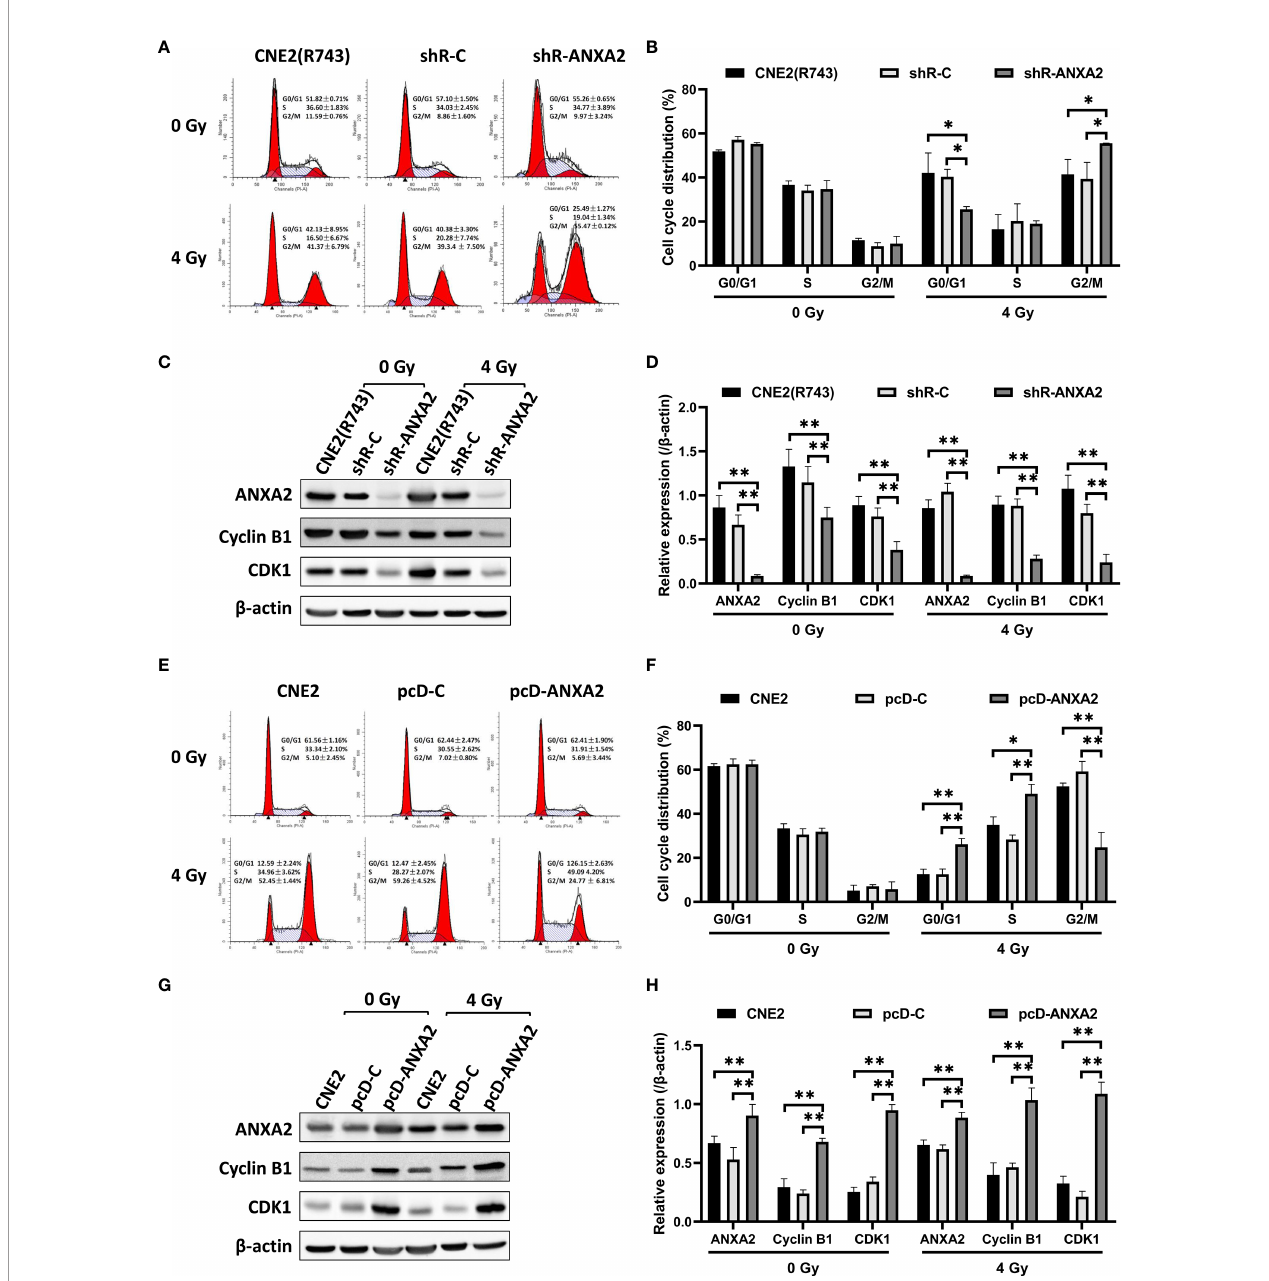
FIGURE 5 | ANXA2 knockdown induces and ANXA2 overexpression abrogates G2/M cell cycle arrest in NPC cells following irradiation. (A) fl ow cytometric analysis detects the cell cycle distribution of shR-ANXA2, shR-C and CNE2(R743) cells 24 h post-exposure to irradiation at doses of 0 and 4 Gy; (B) the percentage of shR- ANXA2 cells with G2/M cell-cycle arrest is signi fi cantly higher than those of shR-C and CNE2(R743) cells 24 h following exposure to irradiation at 4 Gy, no signi fi cant difference is seen in the percentage of shR-ANXA2, shR-C and CNE2(R743) cells with G2/M cell-cycle arrest without irradiation; (C) Western blotting determines the expression of cell cycle-related proteins in shR-ANXA2, shR-C and CNE2(R743) cells 24 h post-exposure to irradiation at doses of 0 and 4 Gy, and b -actin serves as a loading control; (D) lower Cyclin B1 and CDK1 expression is determined in shR-ANXA2 cells than in shR-C and CNE2(R743) cells; (E) fl ow cytometric analysis detects the cell cycle distribution of pcD-ANXA2, pcD-C and CNE2 cells 24 h post-exposure to irradiation at doses of 0 and 4 Gy; (F) a lower proportion of the pcD- ANXA2 cells with G2/M cell-cycle arrest is measured in relative to pcD-C and CNE2 cells 24 h following exposure to irradiation at 4 Gy, and no signi fi cant difference was detected in the proportion of pcD-ANXA2, pcD-C and CNE2 cells with G2/M cell-cycle arrest without irradiation; (G) Western blotting determines the expression of cell cycle-related proteins in pcD-ANXA2, pcD-C and CNE2 cells 24 h post-exposure to irradiation at doses of 0 and 4 Gy, and b -actin serves as a loading control; (H) higher Cyclin B1 and CDK1 expression is detected in pcD-ANXA2 cells than in pcD-C and CNE2 cells. Data are presented as mean ± SD of three experiments. * P < 0.05, ** P <